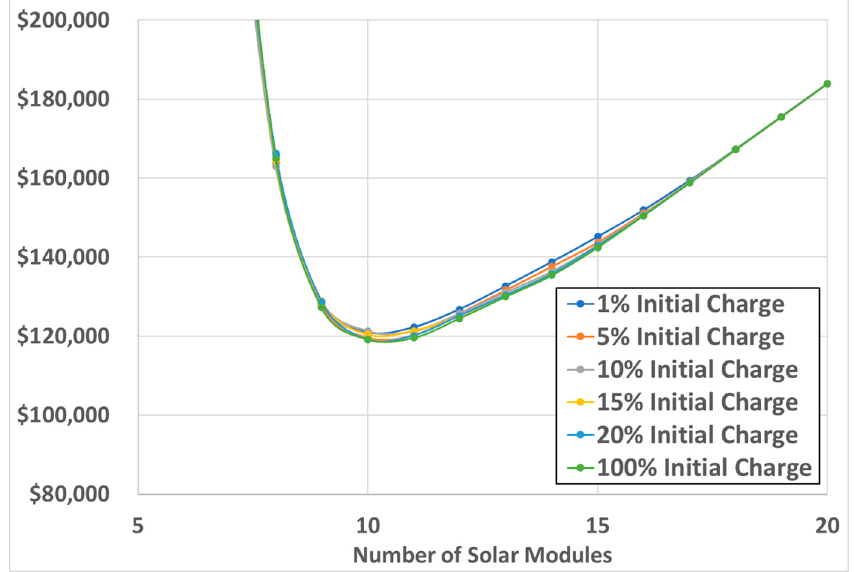
Figure 6. Variable initial charge for IES system given July, five systems, Indianapolis, 0.1% LPSP.